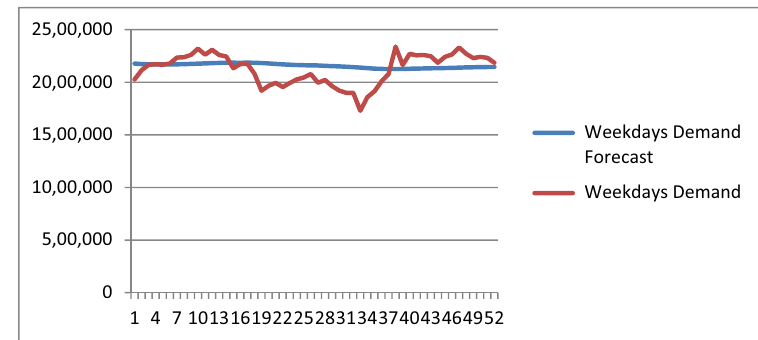
Figure 4: Values obtained as a result of simple average method with test values for weekdays.